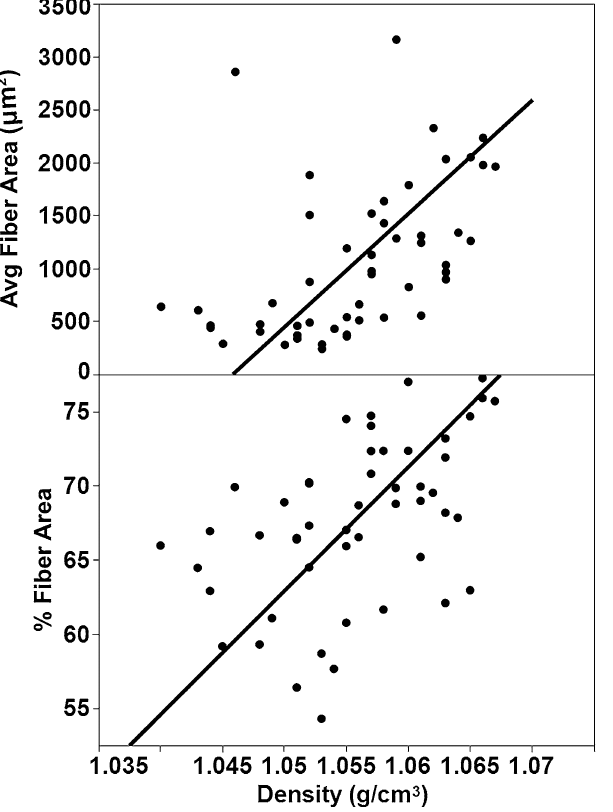
Figure 4. Reduced major axis regressions of average fiber area (top; r 2 = 0.49) and % fiber area against (bottom; r 2 = 0.49) density combined for all muscles and